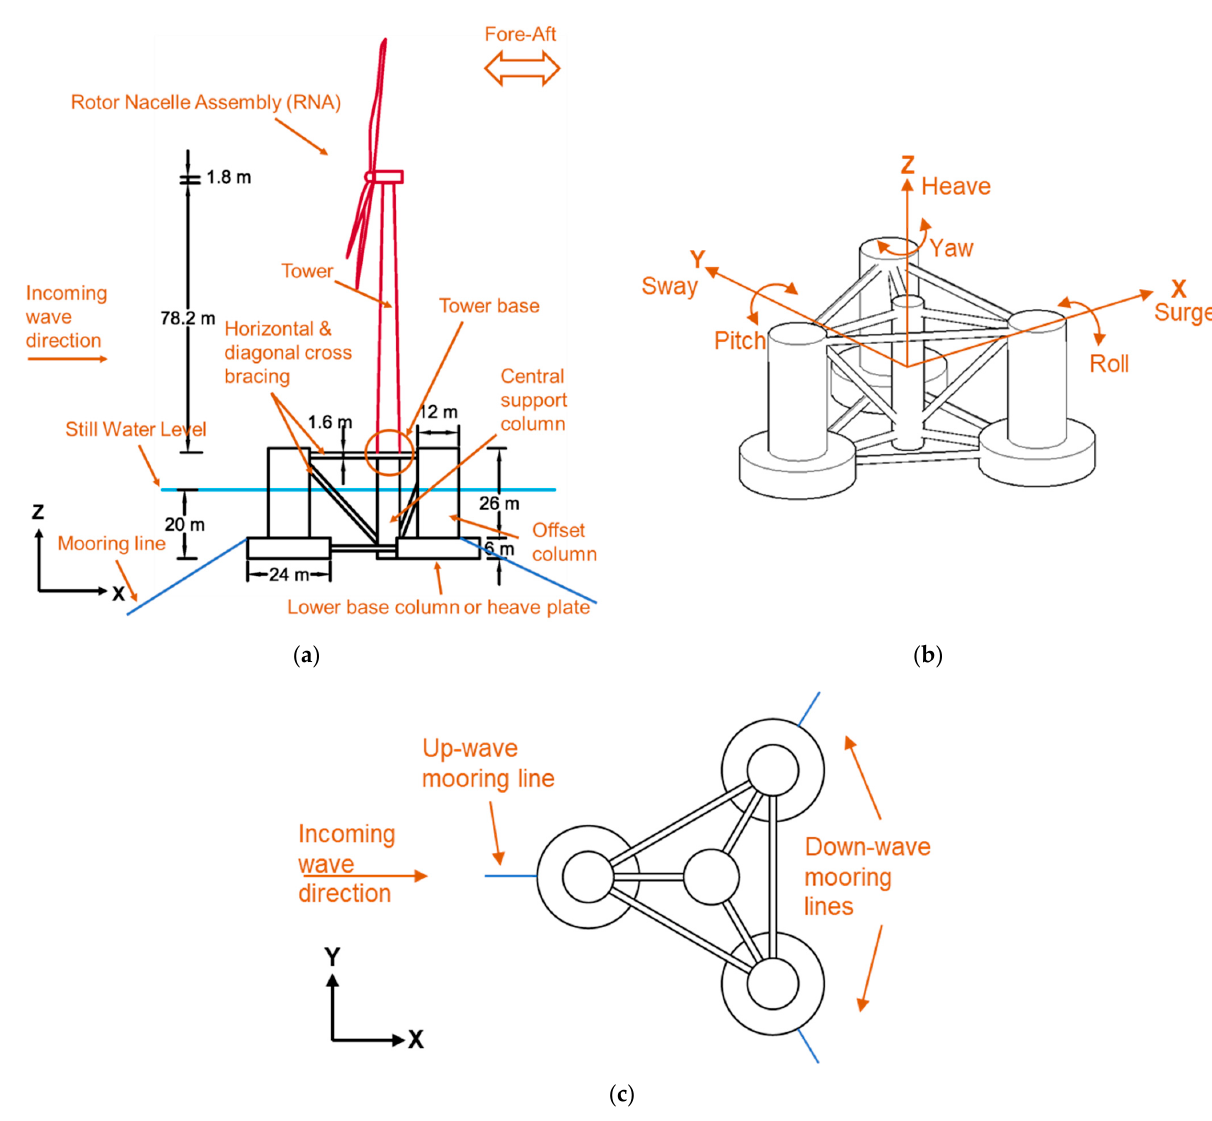
Figure 1. OC5 project FOWT model details: ( a ) FOWT full-scale model side view; ( b ) semi-submersible foundation degrees of freedom; ( c ) semisubmersible foundation top view showing the mooring line setup.